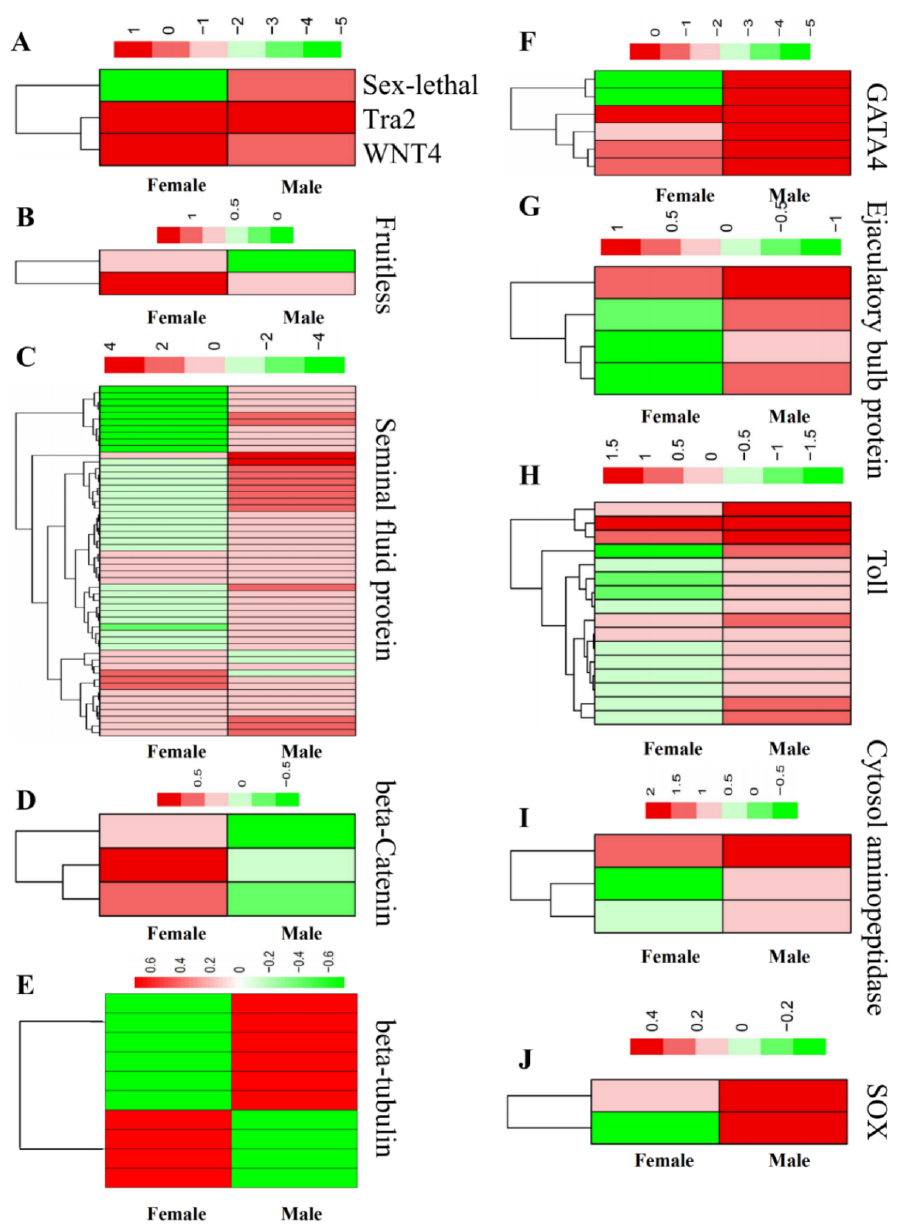
Figure 8. Expression of sex-determining genes in male and female borers. The different horizontal bars represent different gene IDs with the same annotation. The red and green colours indicate increased and decreased gene expression levels, respectively, following the quantitative scale (+ve and -ve numbers) shown above each heatmap. In each heatmap, the left and right columns represent the gene expressions in female and male adults, respectively. The expression patterns of sex-lethal , tra2 and wnt4 ( A ), fruitless ( B ), seminal fluid proteins ( C ), beta-catenin ( D ), beta - tubulin ( E ), gata4 ( F ), ejaculatory bulb-specific protein ( G ), toll ( H ), cytosol aminopeptidase ( I ) and sox ( J ) in the female and male adults.